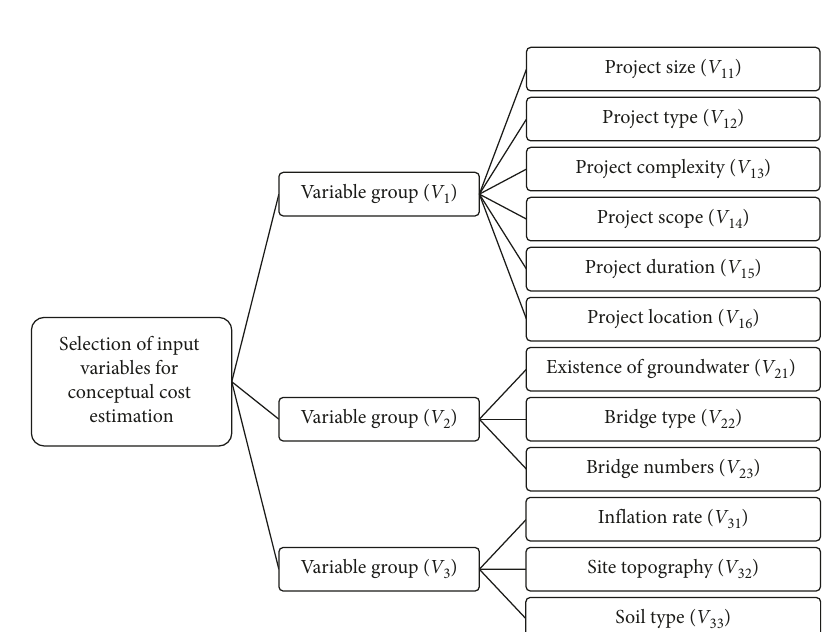
Figure 4: A hierarchical structure for input variable importance weight